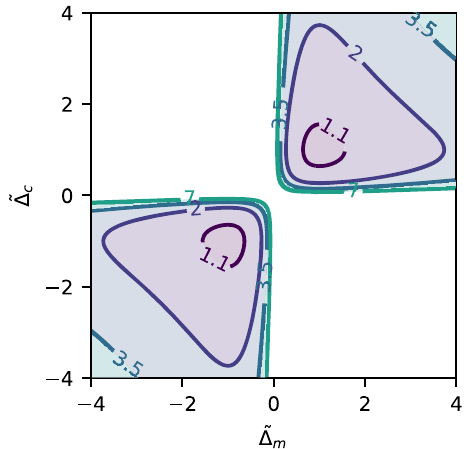
FIG. 3. Domains of two-tone instability. The onset of the two- tone instability is given by the condition Eq. (6) and depends only ˜ Δ ˜ Δ ≡ Δ ≡ Δ = ð Γ = 2 Þ , = ð κ = 2 Þ , and the cooperativity C on m m m c c